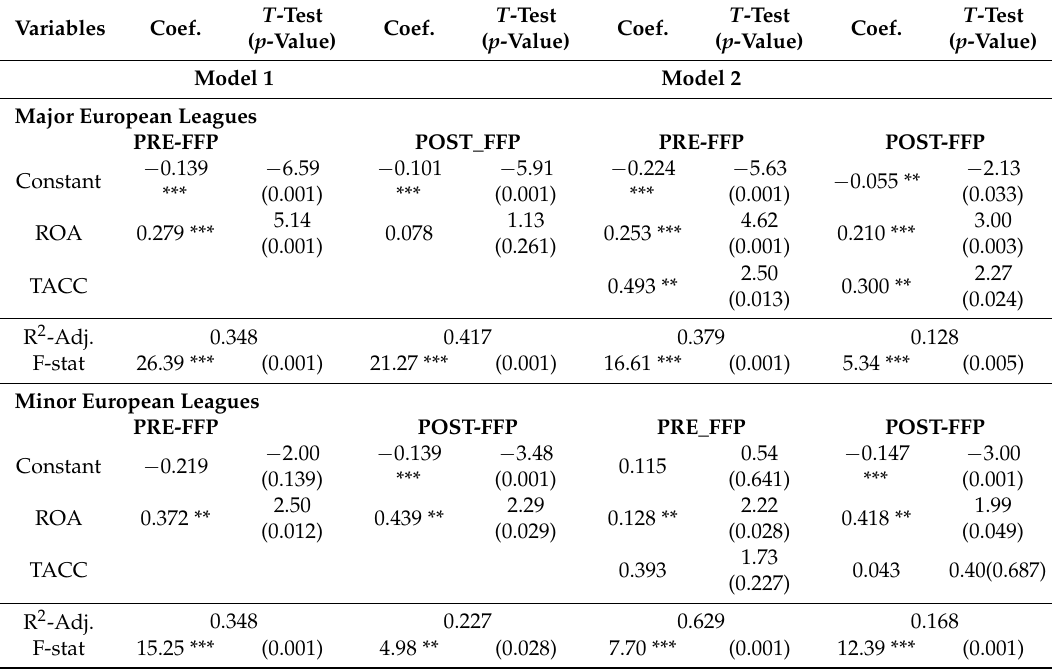
Panel B: Results between major and minor leagues during the pre and post FFP